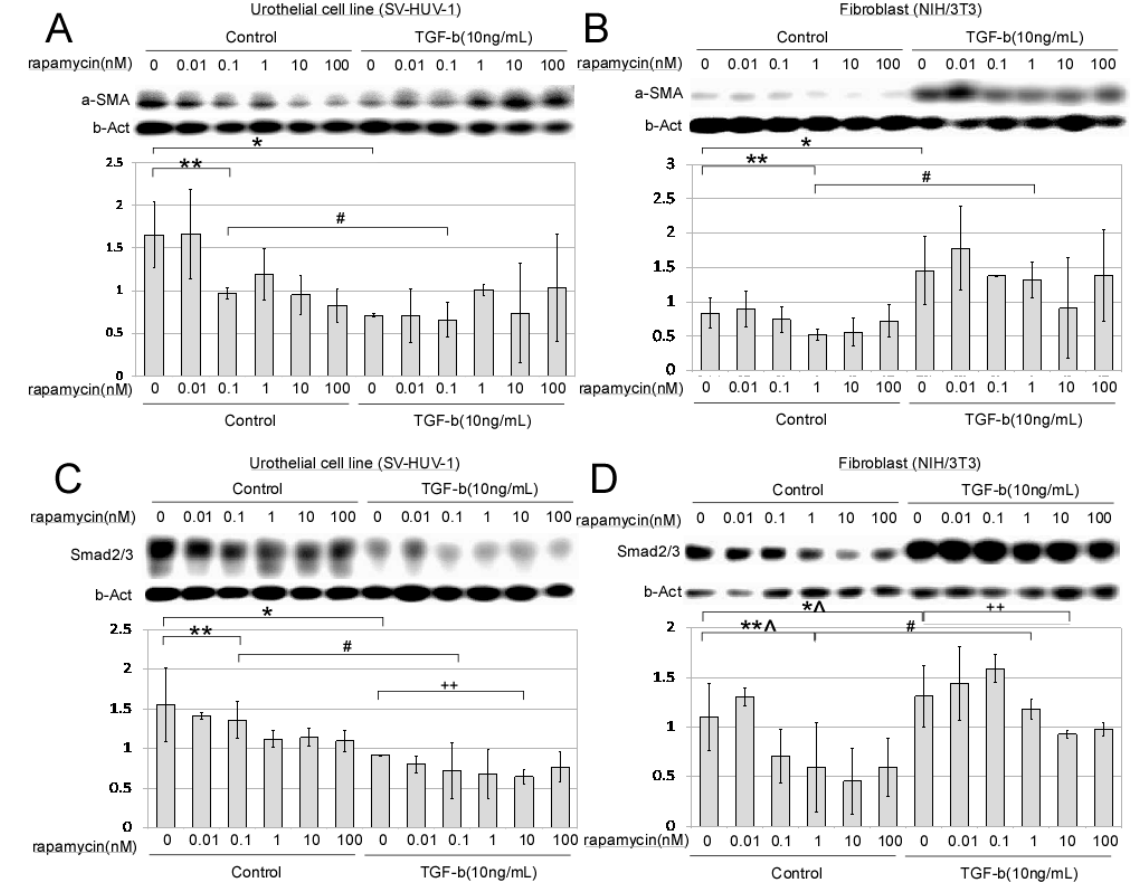
Figure 1. The dose-dependent effect of rapamycin on alpha-smooth muscle actin and Smad protein expression in fibroblast and urothelial cell line. α -SMA expression in ( A ) urothelial cell line and ( B ) fibroblast cell line with or without TGF-b treatment, demonstrating dose-dependent effect of rapamycin. Smad 2/3 expression in ( C ) urothelial cell line and ( D ) fibroblast cell line with or without TGF-b treatment, demonstrating dose-dependent effect of rapamycin. * p < 0.05 represents a significant difference for the TGF-b group compared with the control without TGF-b group, both under no rapamycin treatment. ** p < 0.05 represents a significant difference for the rapamycin treated group compared with the control without rapamycin group, both under no TGF-b treatment. # p < 0.05 represents a significant difference for the TGF-b group compared with the control without TGF-b group, both under specific rapamycin treatment concentration, i.e., 1 nM for fibroblast and 0.1 nM for urothelial cell. *^ p > 0.05 represents an insignificant difference for the TGF-b group compared with the control without TGF-b group, both under no rapamycin treatment. **^ p > 0.05 represents an insignificant difference for the rapamycin treated group compared with the control without rapamycin group, both under no TGF-b treatment. ++ p < 0.05 represents a significant difference for the rapamycin treated group compared with the control without rapamycin group, both under 10 ng/dL TGF-b treatment.